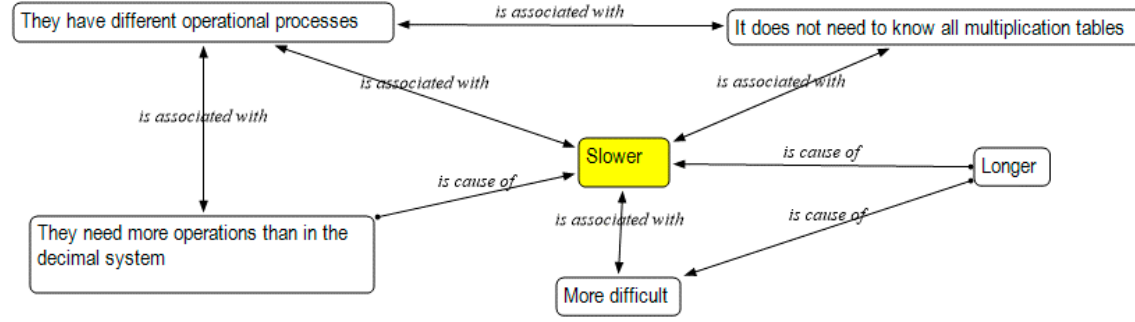
Figure 8. Relations of the slower difference with the categories of procedures and applications.